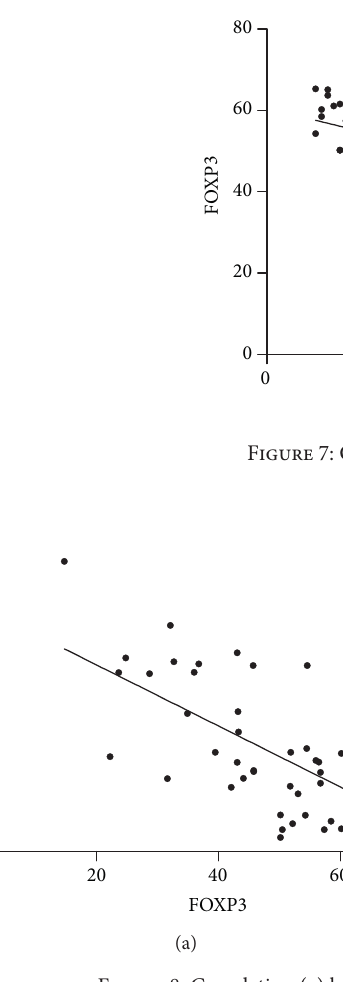
Figure 8: Correlation (a) between FOXP3 and IL-17 and (b) between FOXP3 and